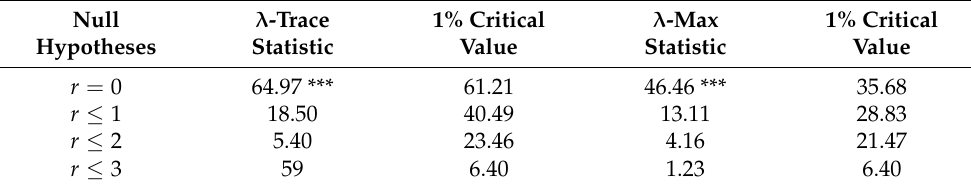
Table 2. Johansen Cointegration Test